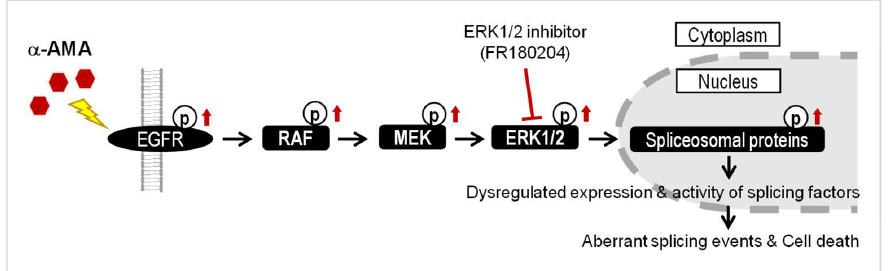
Figure 5. Activation of RAS/RAF/ERK signaling cascades related to α -amanitin ( α -AMA)-induced cytotoxicity in Huh-7 cells. EGFR, epidermal growth factor receptor; RAF, RAF proto-oncogene serine/threonine-protein kinase; MEK, dual specificity mitogen-activated protein kinase; ERK1/2, extracellular signal-regulated kinase 1/2; SAM68, Src associated in mitosis 68 kDa protein; U2AF65, splicing factor U2AF 65 kDa subunit; SPF45, splicing factor 45. Arrow means the increase.